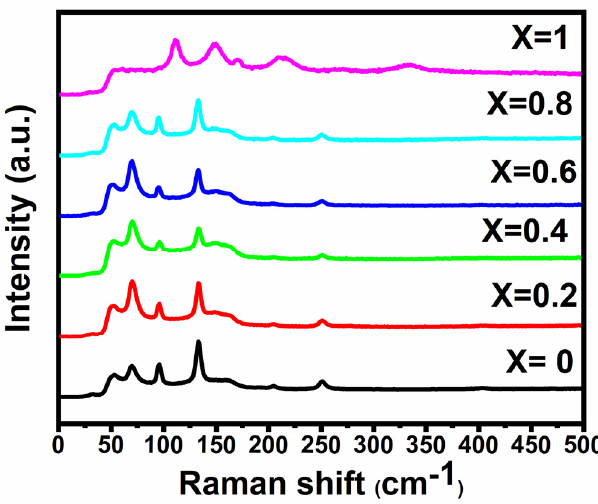
Figure 6. Raman spectra of Sb 2(1 − x ) Fe 2 x S 3 (0 ≤ x ≤ 1) samples prepared by the melt method from a mixture of antimony and iron diethyldithiocarbamate at 450 °C with different mole fractions of Fe.